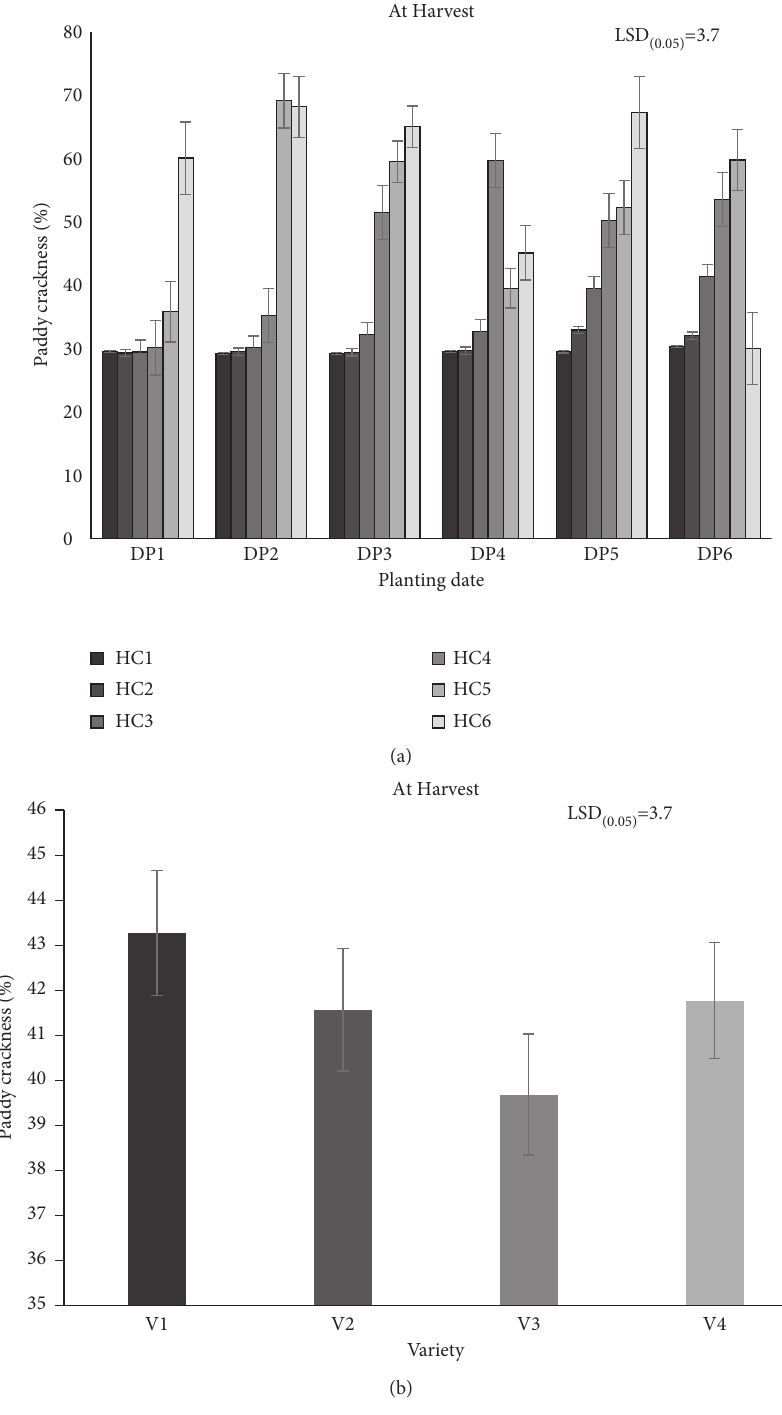
Figure 2: (a) Effect of planting date and harvest cycle on paddy crackness at harvest under rain-fed production systems in the Northern Savanna Agroecological Zone of Ghana. Bars represent the SEM. (b) Effect of perfumed rice varieties on paddy crackness at harvest under rain-fed production systems in the Northern Savanna Agroecological Zone of Ghana. Bars represent the SEM. DP1 � first planting, DP2 � second planting, DP3 � third planting, DP4 � fourth planting, DP5 � fifth planting, DP6 � sixth planting, V1 � Agra, V2 � Gbewaa, V3 � Exbaika, V4 � Perfume Irrigated, HC1 � first harvest, HC2 � second harvest, HC3 � third harvest, HC4 � fourth harvest, HC5 � fifth harvest, and HC6 � sixth